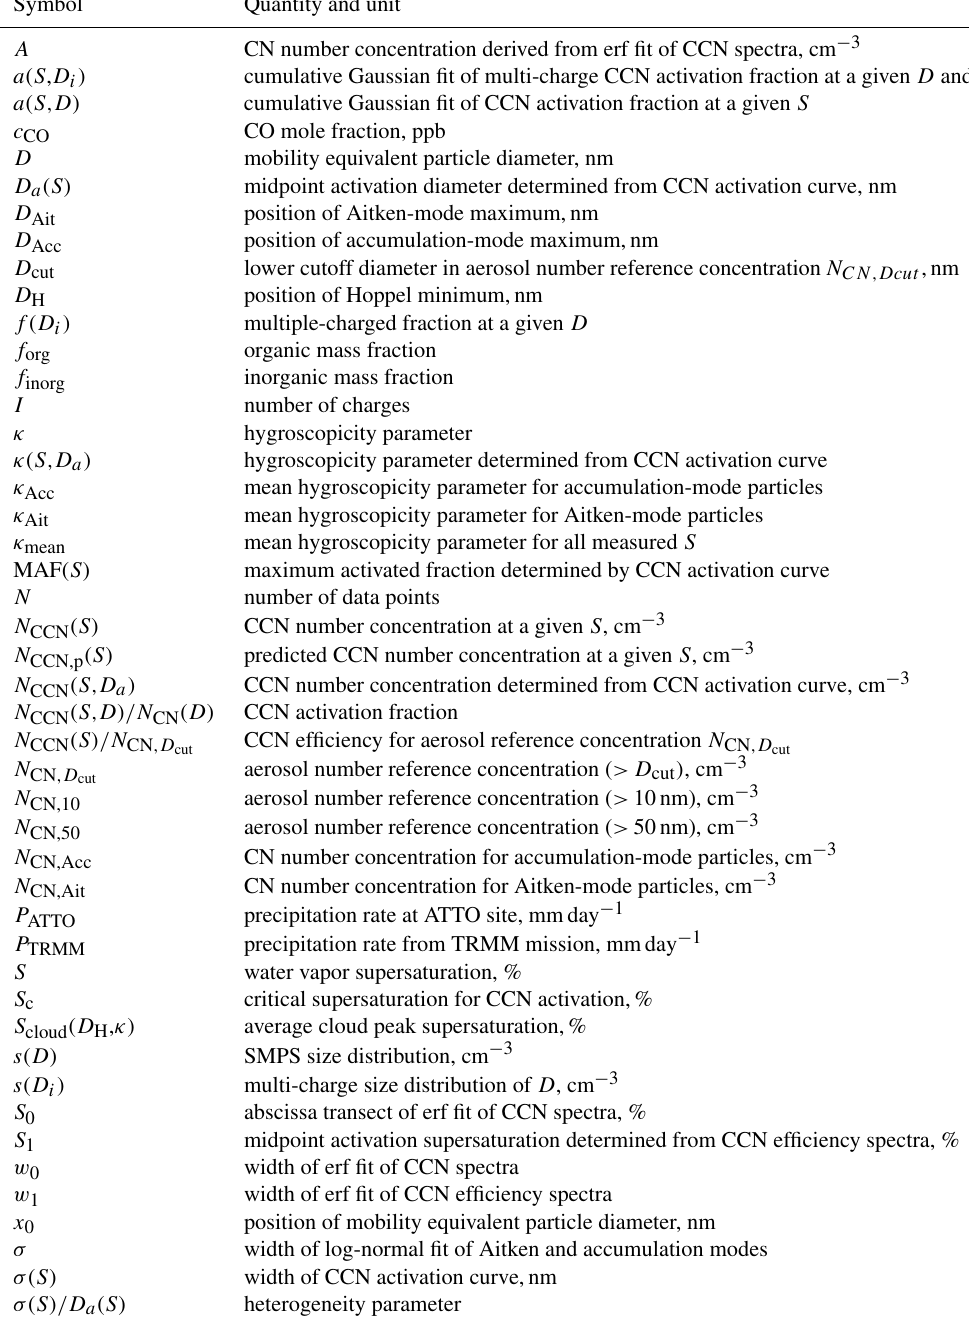
Table A1. List of